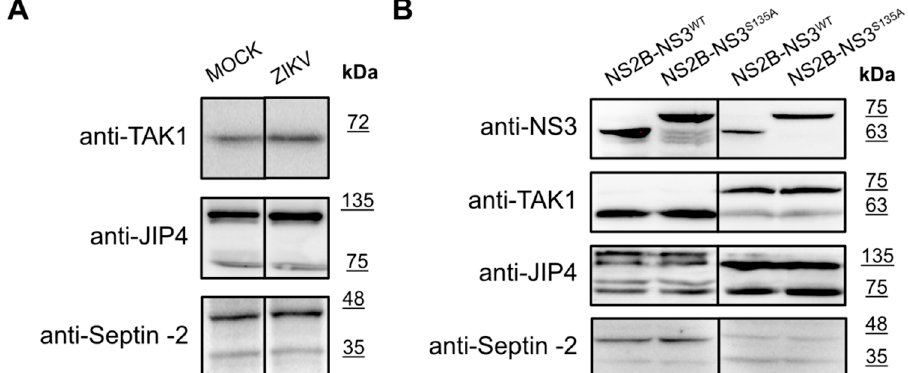
Figure 6. Expression of the TAK1, JIP4, and Septin-2 proteins in ZIKV-infected and mock-infected cells and in cells with expression of active and inactive NS2B-NS3 protease. ( A ) U251 (upper panel), A549 (middle panel), and 293T (bottom panel) cells were infected with ZIKV R103451 Human 2015 Honduras, PRVABC59 or H/PAN/2016 strains, respectively, or inoculated with mock and analyzed by Western blotting. The TAK1, JIP4, and Septin-2 proteins were detected with specific antibodies. ( B ) 293T (left panel) and A549 (right) cells expressing NS2B-NS3 WT or NS2B-NS3 S135A were analyzed. Cells were harvested at 48 h after transfection, lysed, and lysates were analyzed by Western blotting. Levels and profiles of expression of TAK1, JIP4, and Septin-2 proteins were compared in a cell with an expression of active and inactive. Protease expression was confirmed by the presence of NS3 protein in both cell lines (upper panel).